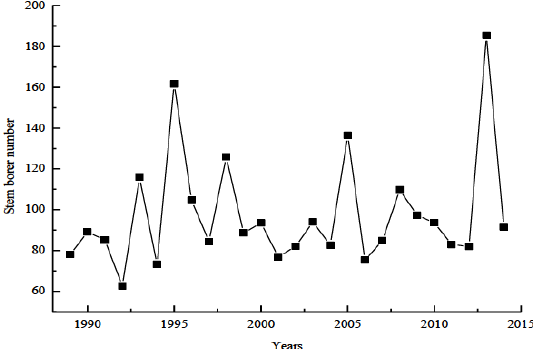
Figure 2: The occurrence amount of stem borers